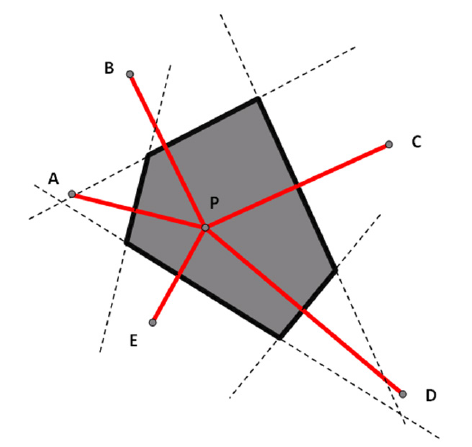
Fig. 2. Graphic representation of Voronoi polygons (own